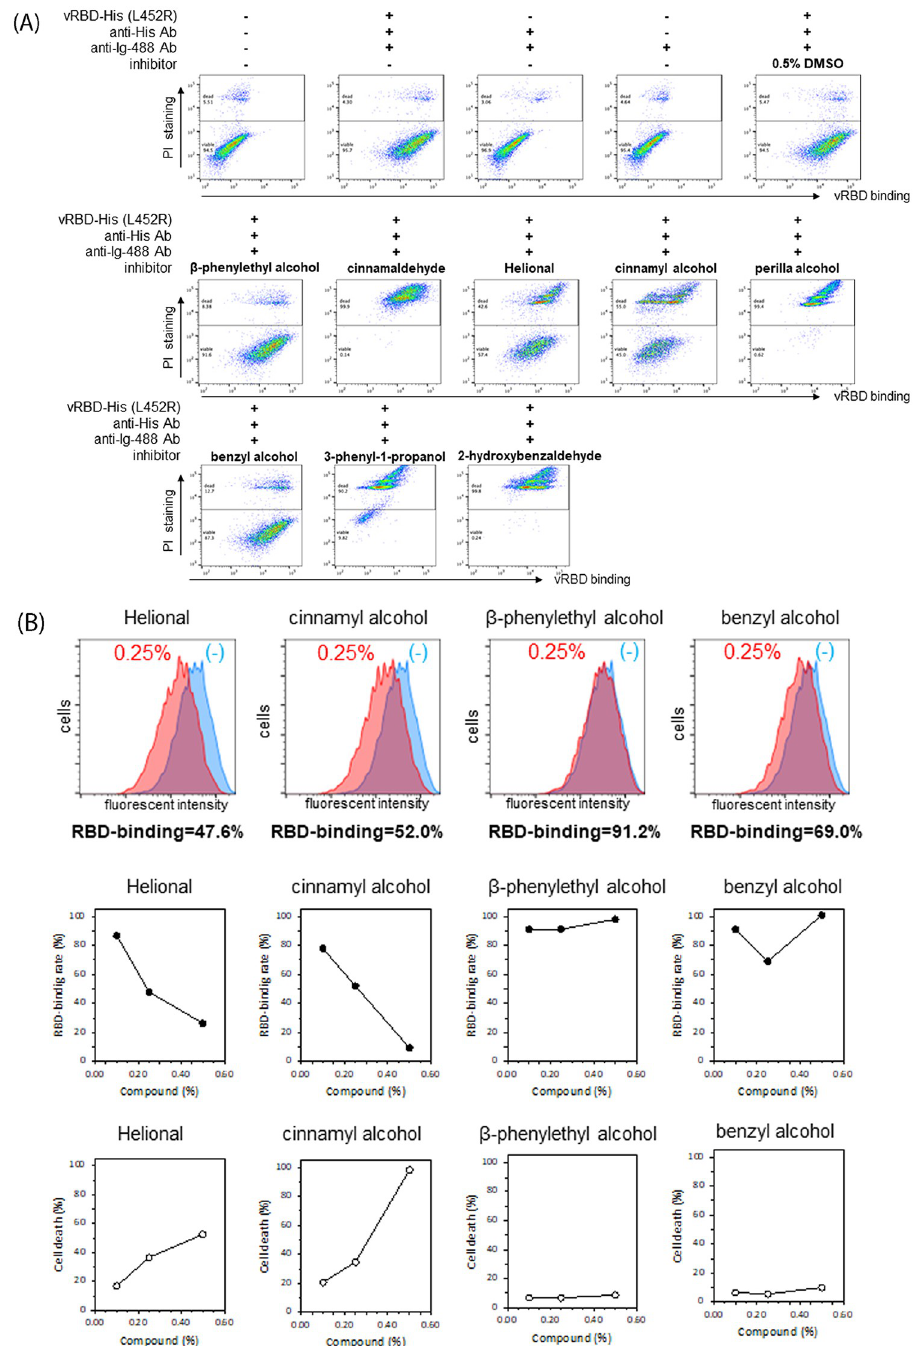
Fig 5. Analysis of inhibitory activities of flavor/fragrance compositions at the cellular level. Flow-cytometry was performed with histidine-tagged Omicron (BA.1.1.529) vRBD and the ACE2-expressing VeroE6/TMPRSS2 cells. (A) Dot plots of vRBD-bound VeroE6/TMPRSS2 cells. Cells were stained with propidium iodide (PI) to check viability as well as anti-histidine antibody, followed by detection with anti-immunoglobulin-Alexa488 fluorescence. PI-positive dead cells were plotted in the upper part of the plots. (B) [Top row] Histograms of vRBD-bound VeroE6/TMPRSS2 cells with (red) or without (light blue) flavor/fragrance compositions. RBD-binding rates are shown under the histogram. [Middle row] Binding rate at different concentrations of flavor/fragrance compositions. Relative binding values were calculated based on the negative control without flavor/fragrance compositions. [Bottom row] Viability of VeroE6/TMPRSS2 cells at various concentrations of flavor/fragrance compositions. Dead cells were determined using PI-staining. Data are representative of three independent experiments. https://doi.org/10.1371/journal.pone.0279182.g005 PLOS ONE | https://doi.org/10.1371/journal.pone.0279182 December19,